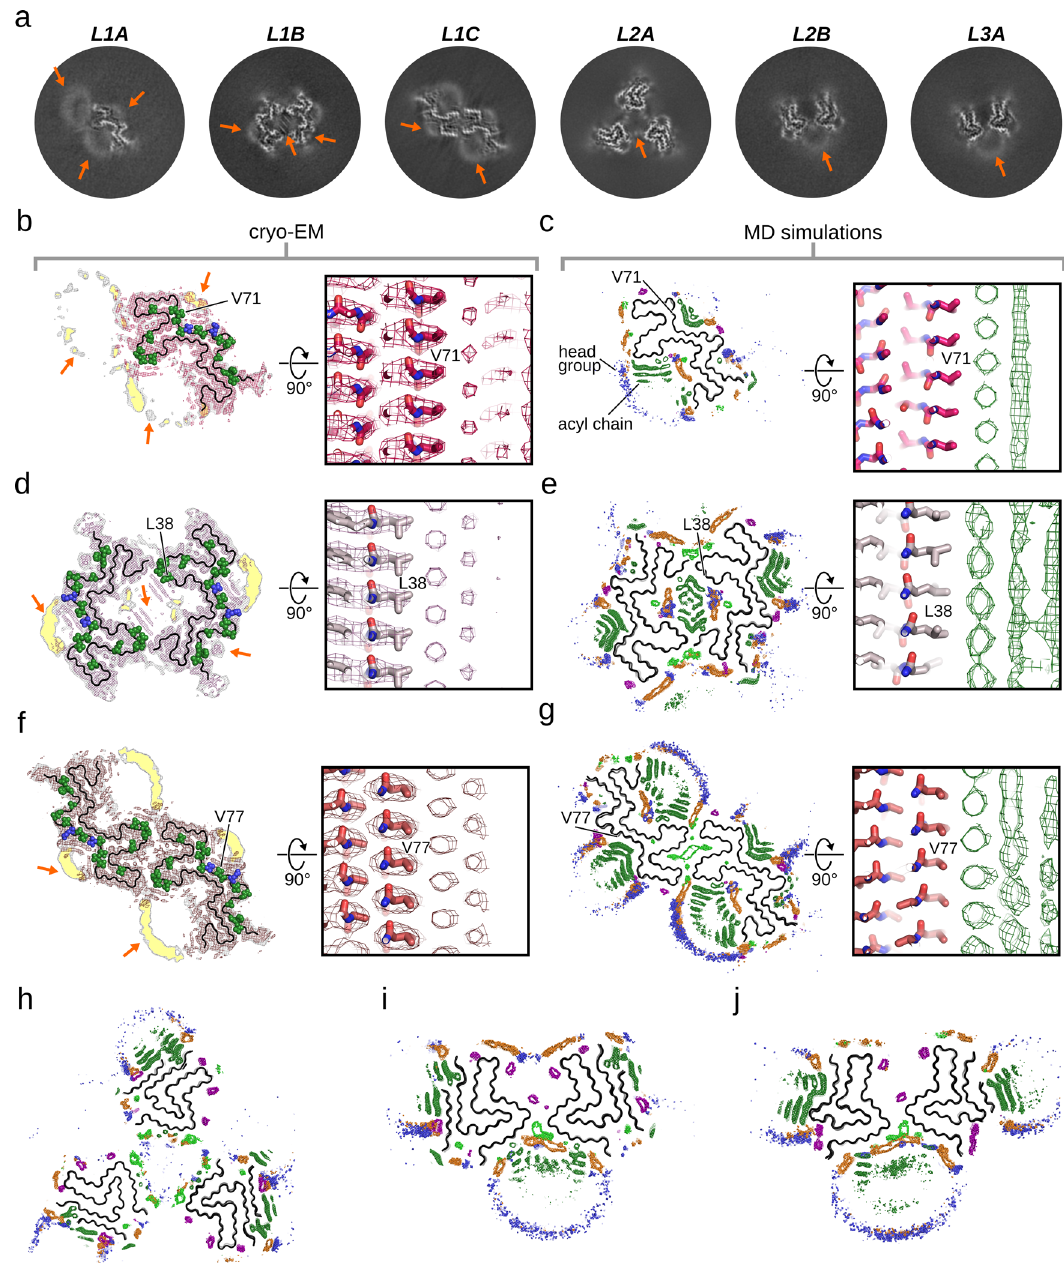
Fig.3|Lipid- fi brilinteractions.a Centralsliceoftheunsharpenedre fi nedcryo-EM maps. b , d , f Superposition of the reconstructed cryo-EM maps and the atomic model. Sharpened, high-resolution maps are shown in magenta ( b , L1A), violet ( d , L1B), and red ( f , L1C). Unsharpened, 4.5Å low-pass fi ltered density is shown in gray.Thebackboneofthemodelisshownasblackribbon,withresiduesbindingto the acyl chain (green) or choline moiety (blue) of phospholipids shown as spheres 20 . In ( a , b , d , f ) the arrows highlight non- fi brillar densities. c , e , g The grids